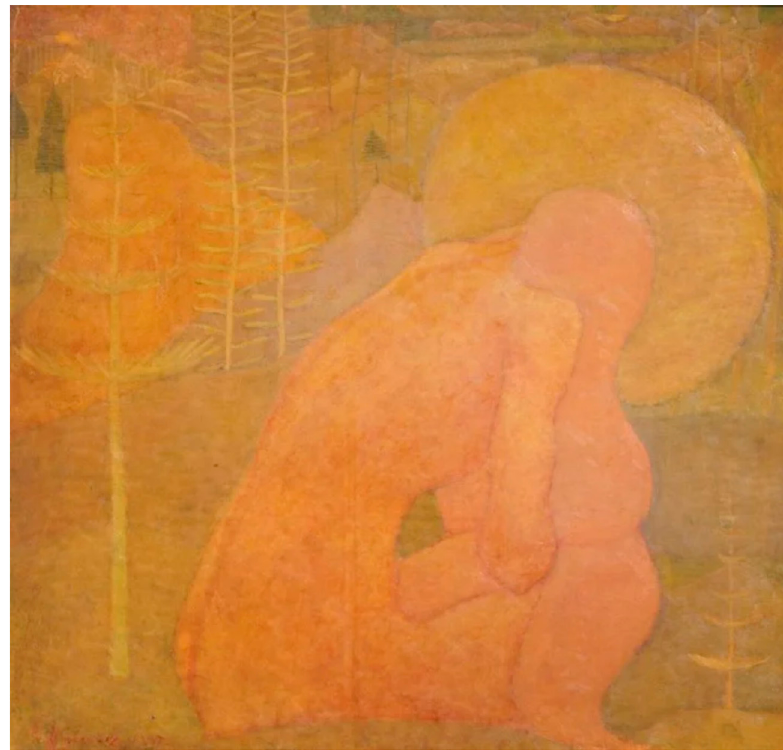
Figure 13. Kazimir Malevich, Prayer, 1907.